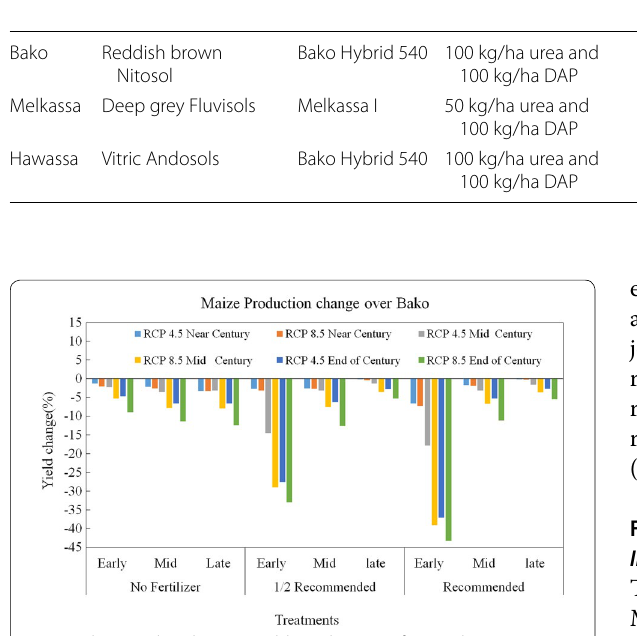
Fig. 5 The Simulated maize yield in relation to future climate sce- nario at